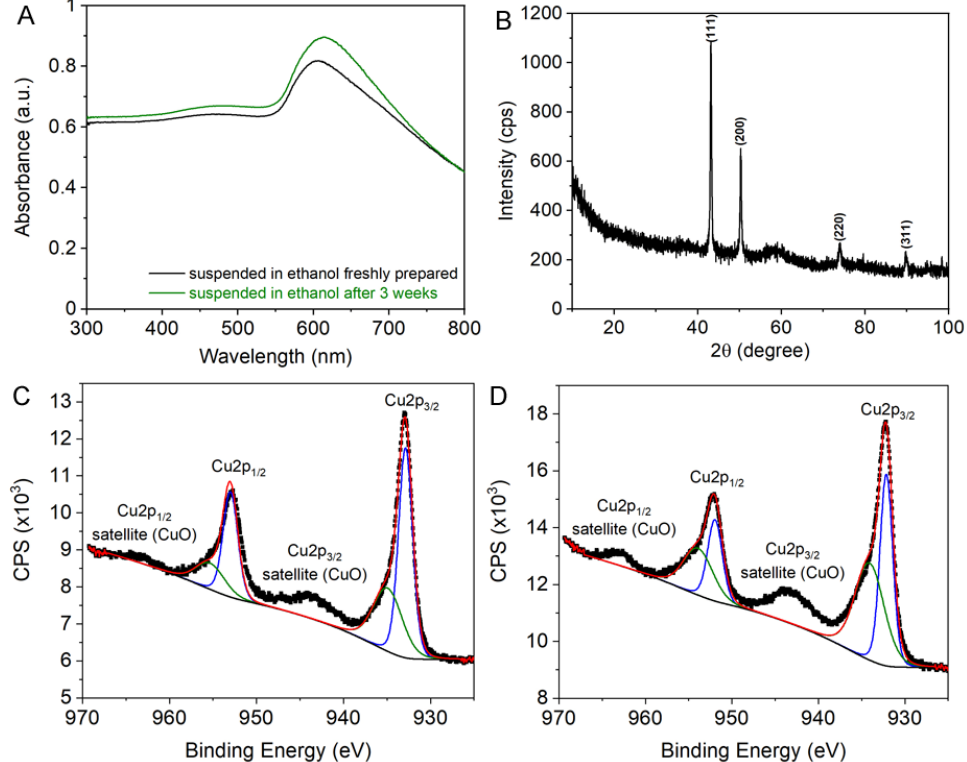
Figure 4. ( A ) UV-vis spectra of the PEG-SH coated CuNPs suspended in ethanol freshly prepared and after 3 weeks. ( B ) XRD of the PEG-SH coated CuNPs after 5 days suspended in ethanol. ( C , D ) Cu2p XPS of the PEG-SH coated CuNPs freshly prepared ( C ) and after 5 days suspended in ethanol ( D ). The red curve is the sum of blue and green curves that fit Cu2p 3/2 and Cu2p 1/2 regions with Cu/Cu 2 O and CuO, respectively.